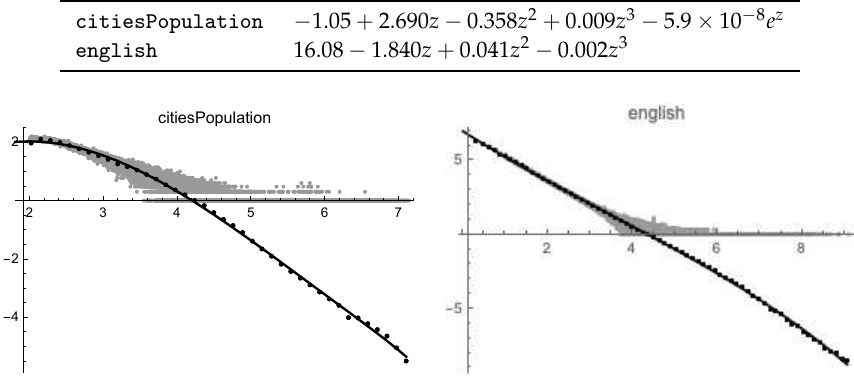
Figure 5. Log-log solutions of citiesPopulation ( on the left ) and of english ( on the right